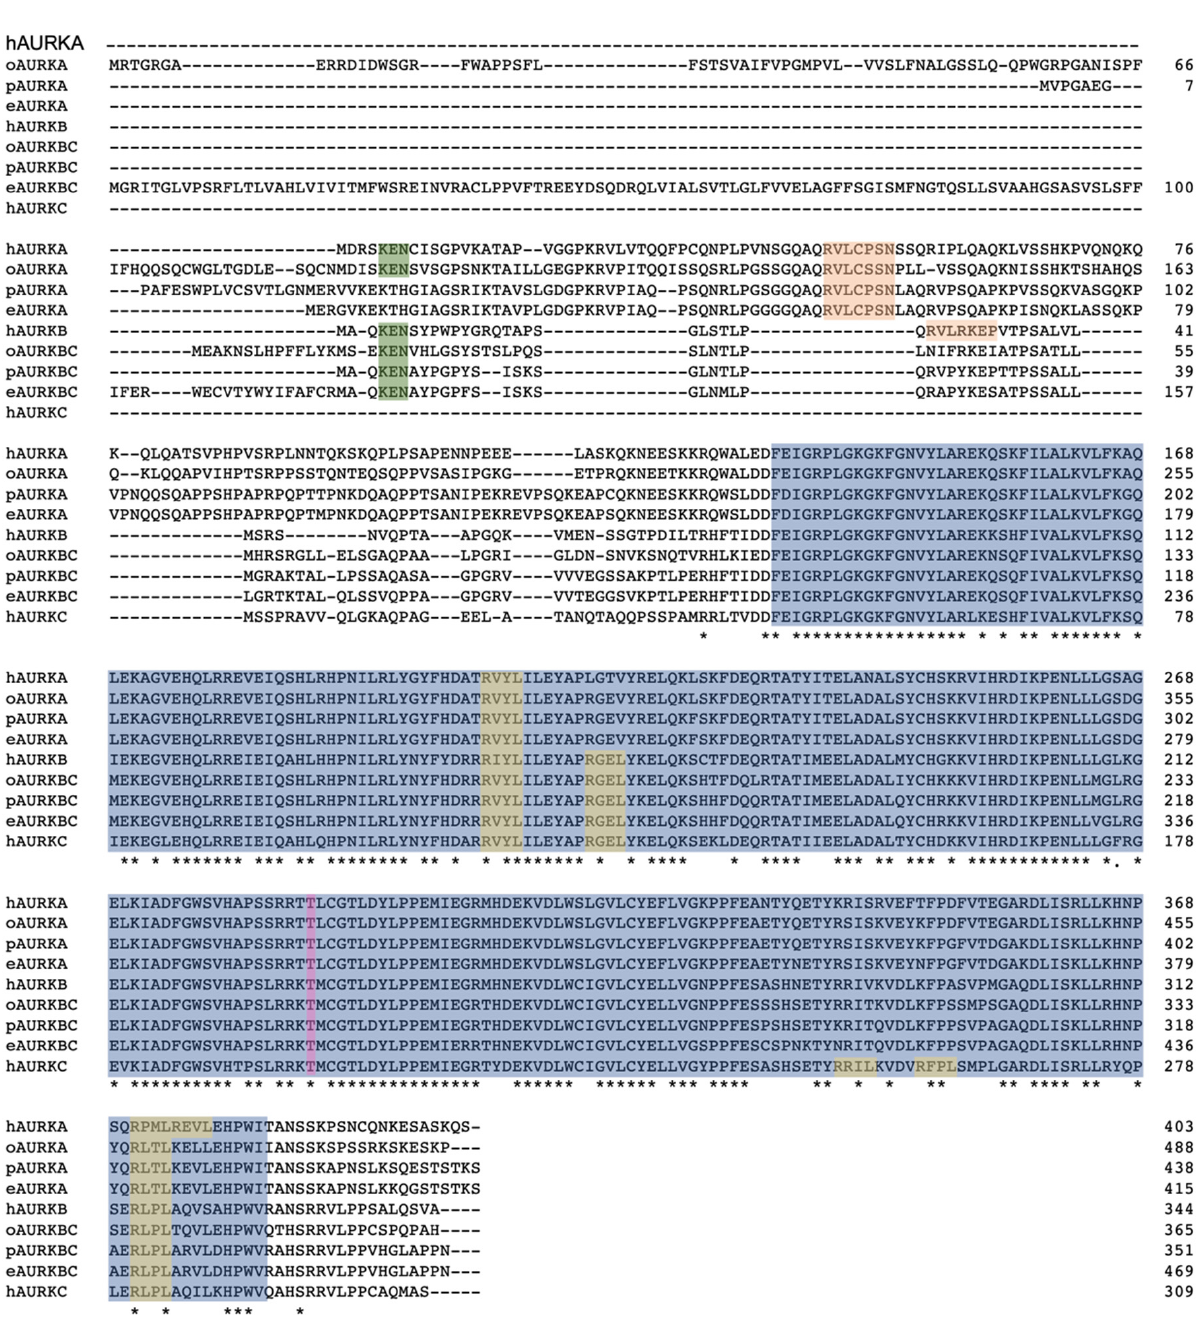
Figure 3. Alignment of AURK proteins of human (h), opossum (o), platypus (p), and echidna (e). The kinase domain is highlighted in blue; the degrons were identified by comparison with those of the human AURK proteins [29]; the KEN box in green; the DAD/A box in orange; the D-Box in yellow; and the Threonine, which becomes phosphorylated for enzyme activity, is highlighted in pink. *, fully conserved residue.